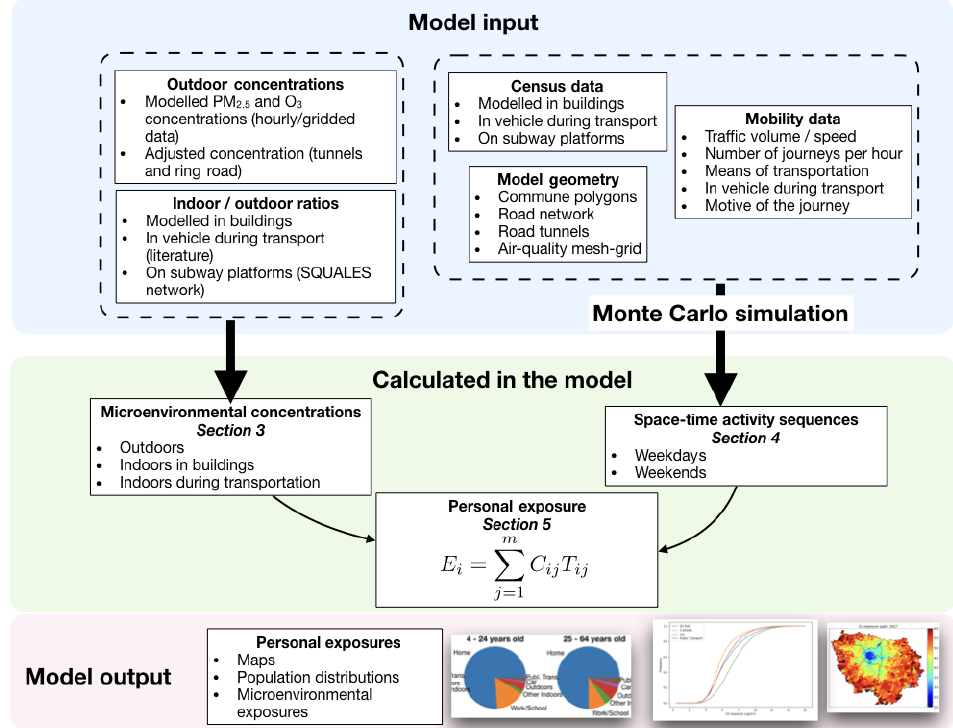
Figure 1. Overview of the EXposure to atmospheric PolLUtion ModEling (EXPLUME) model structure from the input data to the exposure